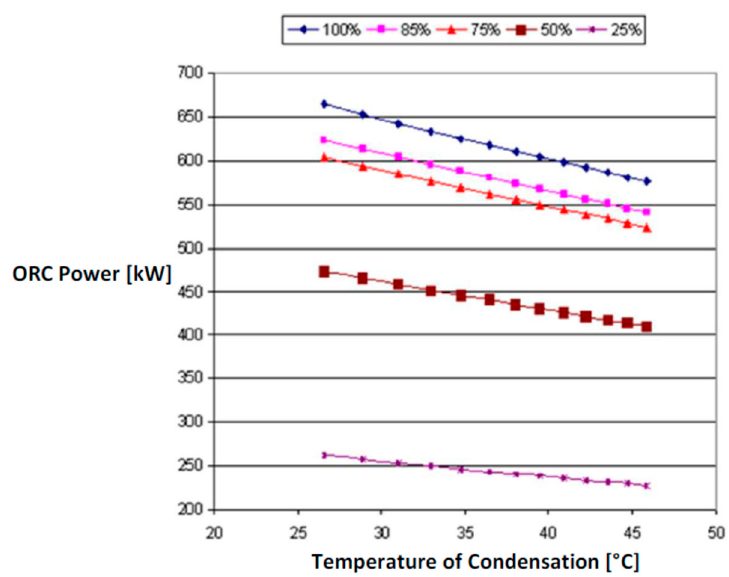
Figure 6. ORC power vs. condensation temperature, for different engine loads and maximum pressure equal to 20 bar.